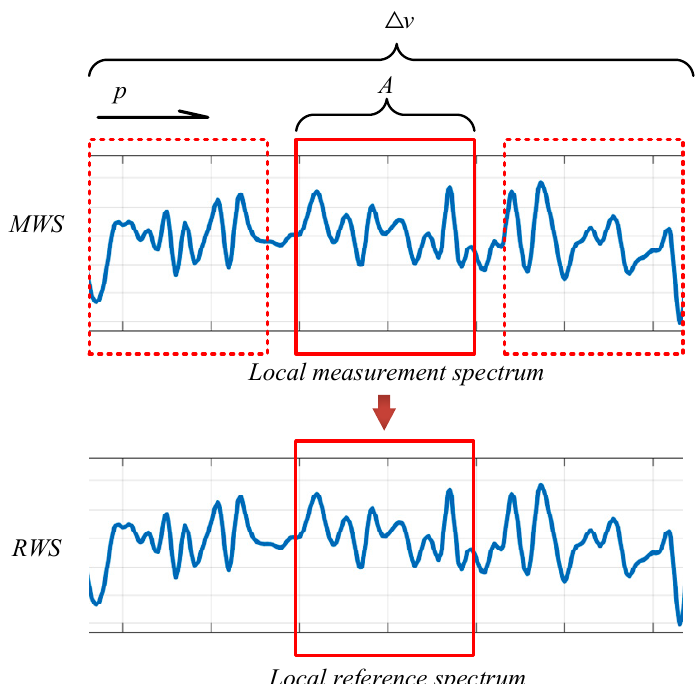
Figure 3. Schematic diagram of demodulation method based on local similarity. The local measured Rayleigh signal (LMS) is obtained by intercepting the measured whole Rayleigh scattering signal (MWS) with a rectangular frame of length A, and its position is represented by p . A local reference Rayleigh signal (LRS) of length A is intercepted at the middle of the reference whole Rayleigh scattering signal (RWS). The correlation coefficient between the LRS and the LMS is calculated at each position.